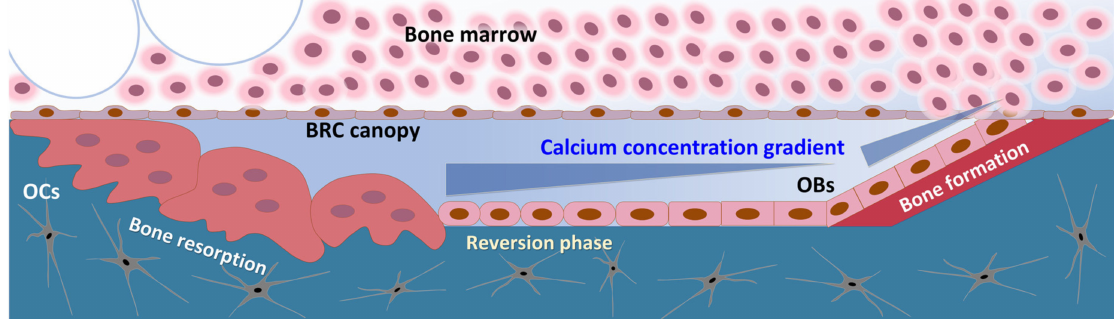
Figure 6. The schematic drawing of BRC (bone remodeling compartment). Compartmentalization of the BRC by canopy cells resulted in the establishment of concentration gradient of the chemoattractant released by the action of bone-resorbing os-